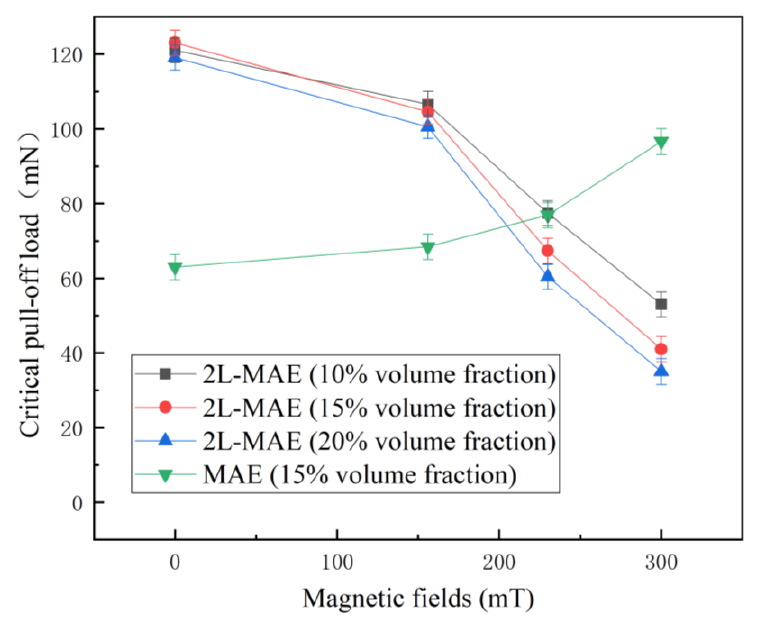
Figure 9. Critical pull-off load vs. external magnetic fields curves when the MAE samples detached from an iron sheet.